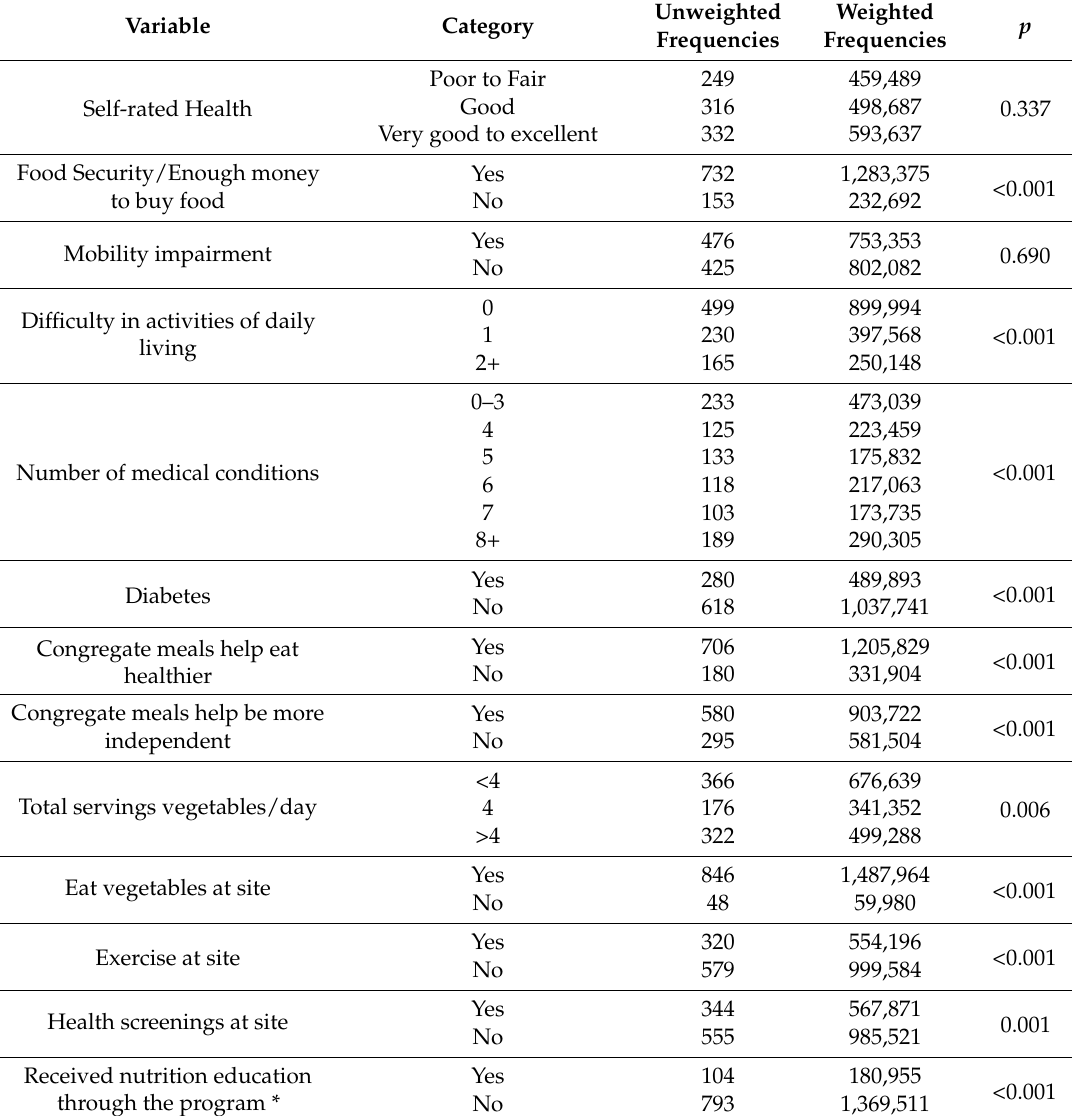
Table 2. Health-related characteristics of the